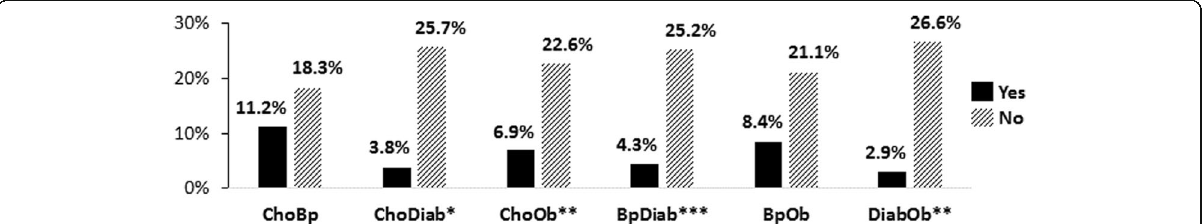
Fig. 2 CAM Use by Disease Dyads. [Yes = Used CAM and had the disease dyad; No = Used CAM but did not have the disease dyad]; Disease Dyads: ChoBp = Hypercholesterolemia and Hypertension; ChoDiab = Hypercholesterolemia and Diabetes; ChoOb = Hypercholesterolemia and Obesity; BpDiab= Hypertension and Diabetes; BpOb = Hypertension and Obesity; DiabOb = Diabetes and Obesity; Significance levels: * p < 0.05 , ** p < 0.01 , *** p <